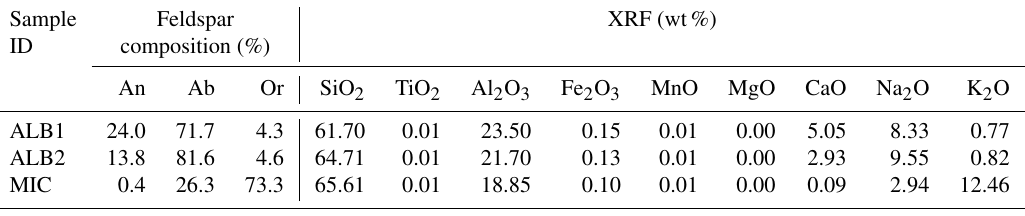
Table 1. Bulk chemical composition of samples ALB1, ALB2, and MIC determined by X-ray fluorescence (XRF) and expressed as percent oxide. The Ca, Na, and K contents were used to determine the composition of each feldspar sample compared to the pure calcic (An), sodic (Ab), and potassic (Or) end-members.